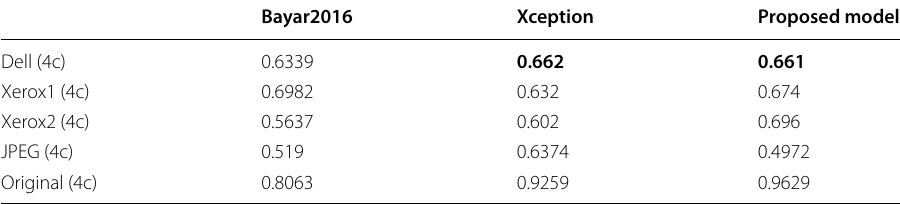
Table 6 Validation accuracy for various validation sets after training on the Composite Printers data